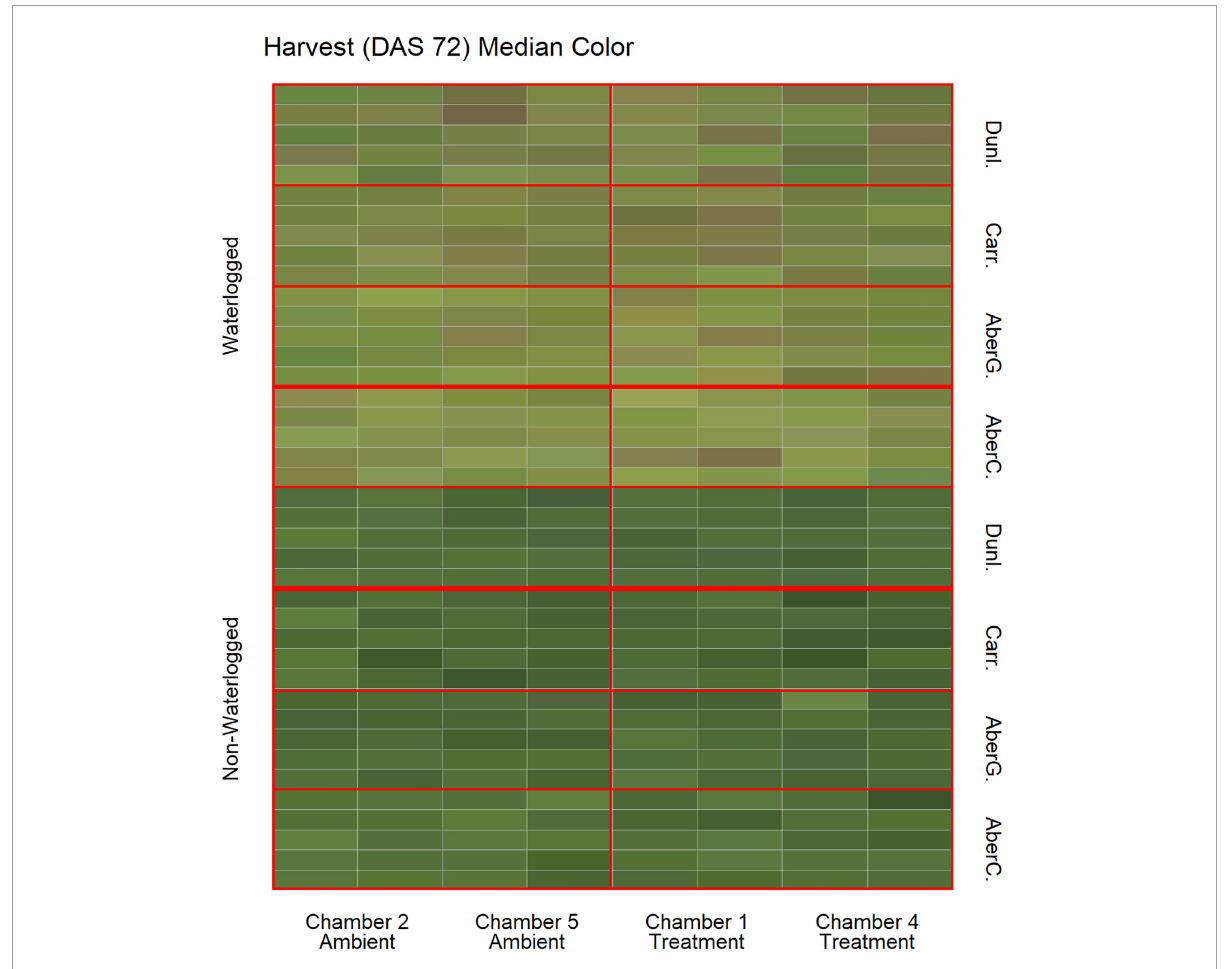
FIGURE3 Median color (RGB) of the harvested material for all cores on DAS 72 as identified by the image analysis, sorted on water status, climate treatment and variety. Each cell represents the median true color of the harvested material of a plant. AberC, Aberchoice; AberG, Abergain; Carr, Carraig; Dunl,